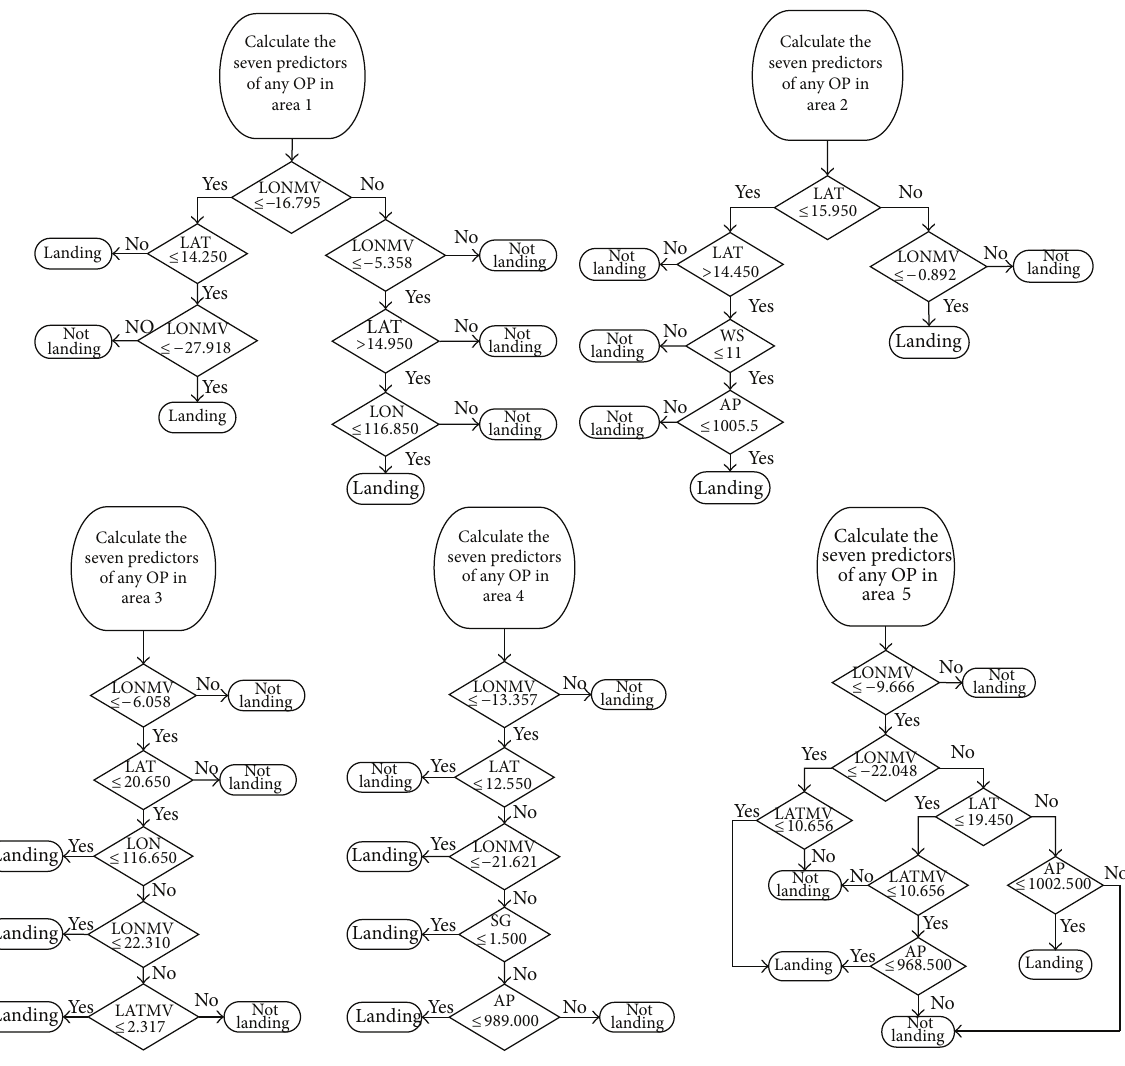
Figure 10: The landing criterions in five areas.